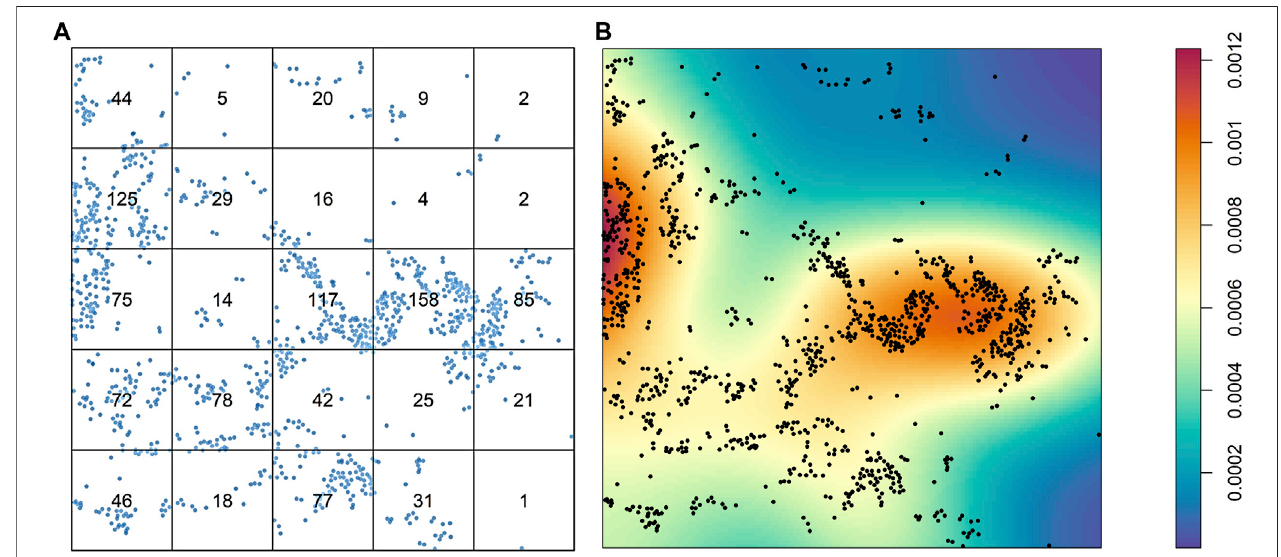
FIGURE 3 | Characterization of the distribution of cells from a sample of lung adenocarcinoma in a multiplex immuno fl uorescence image. (A) Results of quadrant analysis, with each quadrant containing the exact number of cells in a square, represented by dots. (B) Heat map of Kernel smoothing from the same area of the image, showing areas of high and low proliferation of cells, identi fi ed by colored regions (see color scale at right). The images were generated using R studio software version